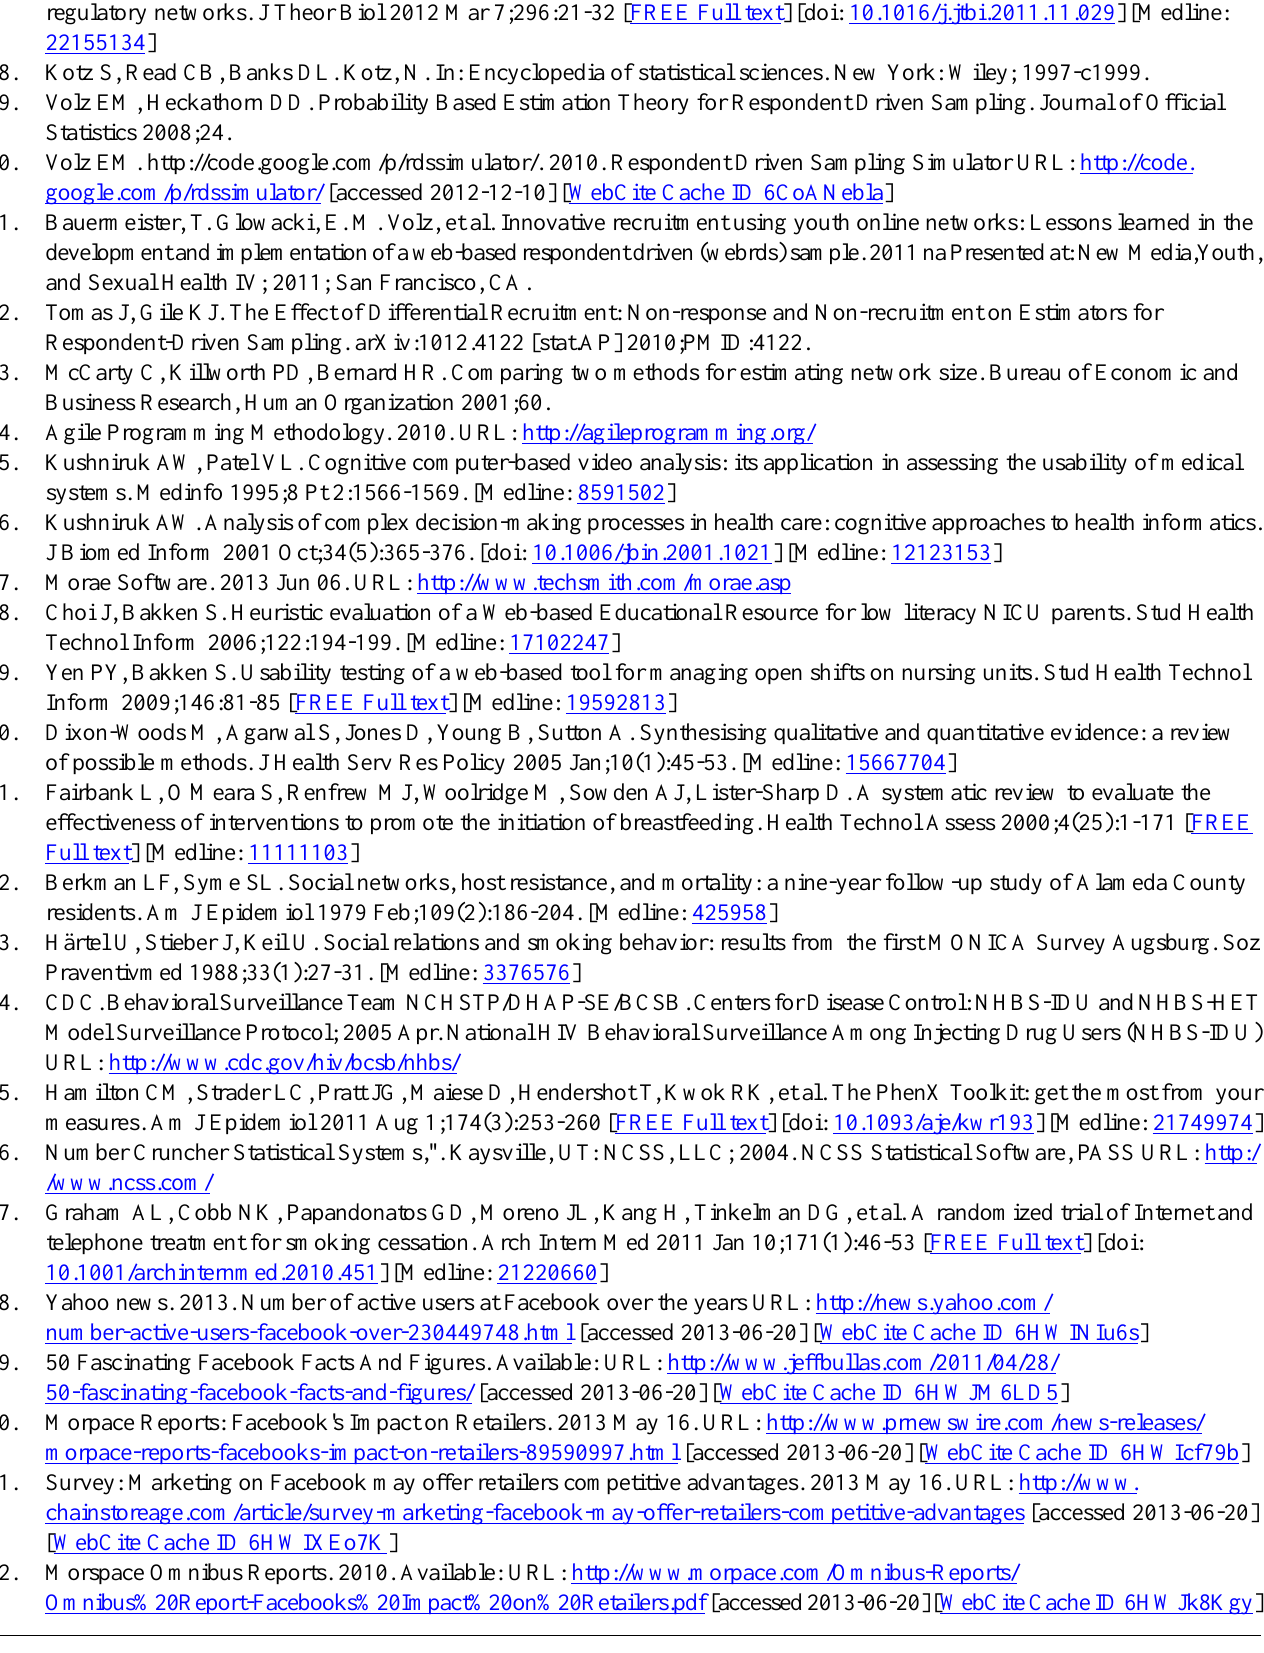
HIPAA: Health Insurance Portability and Accountability